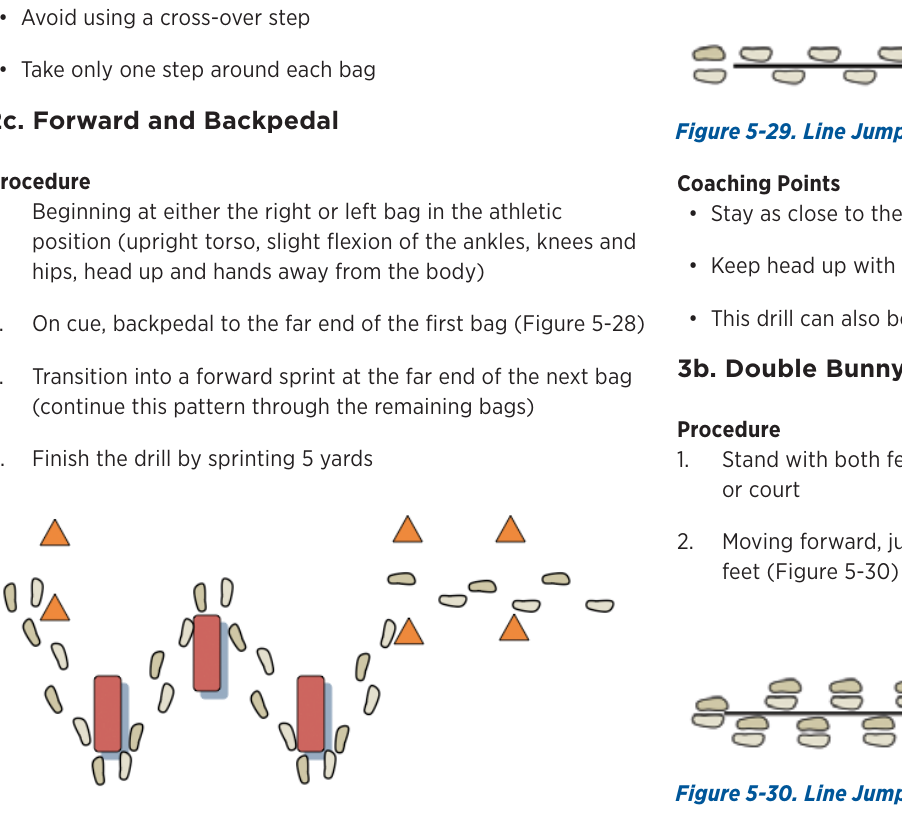
Figure 5-27. Bag Routine – Shuffle